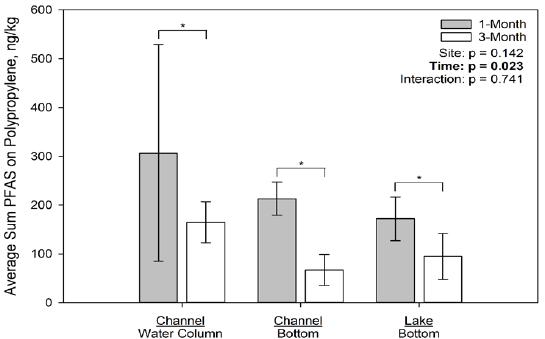
Figure 3. Average Sum of 7 PFAS (ng/kg) on Polyethylene Deployed at Different Locations in Muskegon Lake, MI. Different letters among bars indicate statistically significant differences among sites for either the 1 month or 3 month incubation period. Asterisks indicate statistically significant differences between the 1 month vs. 3 month incubation at a specific site.